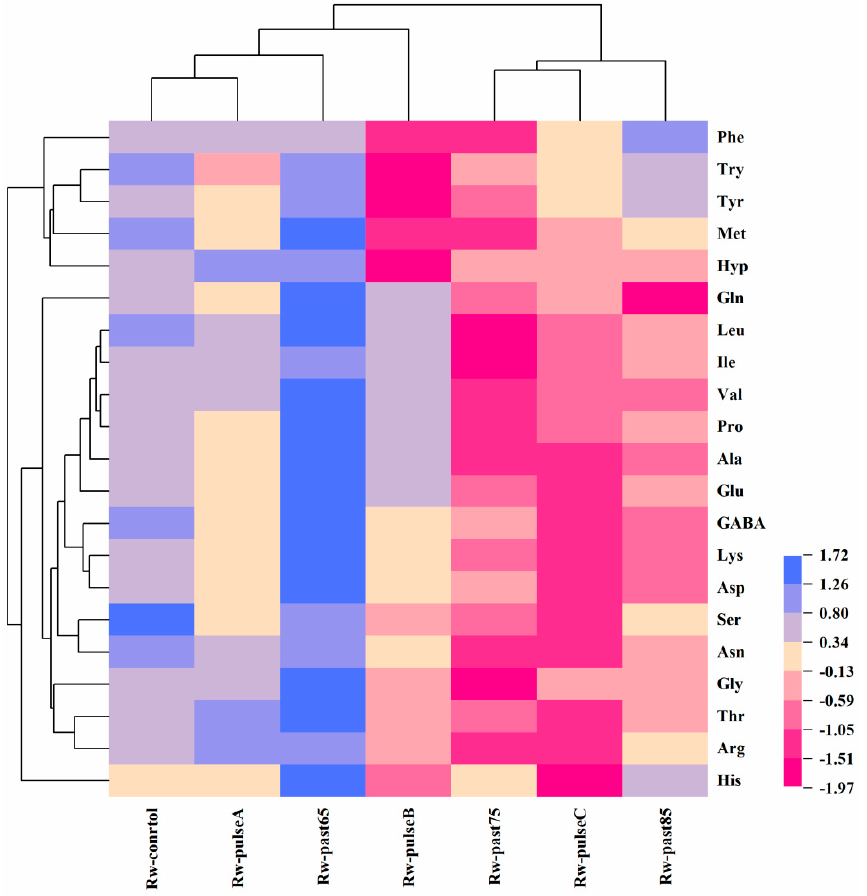
Figure 3. The difference of 21 free amino acids between unsterilized and other sterilized SRW.